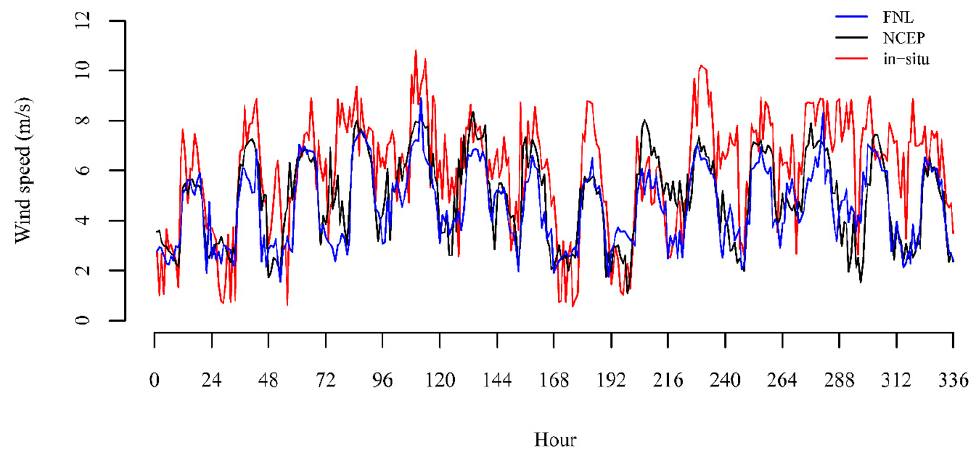
Figure 5. 10 m level wind speed time series at Crown Point for 1–14 April 2003 from in-situ data (red line) compared with WRF model simulations initialized with FNL data (blue line) and those with NCEP-DOE reanalysis data (black line).